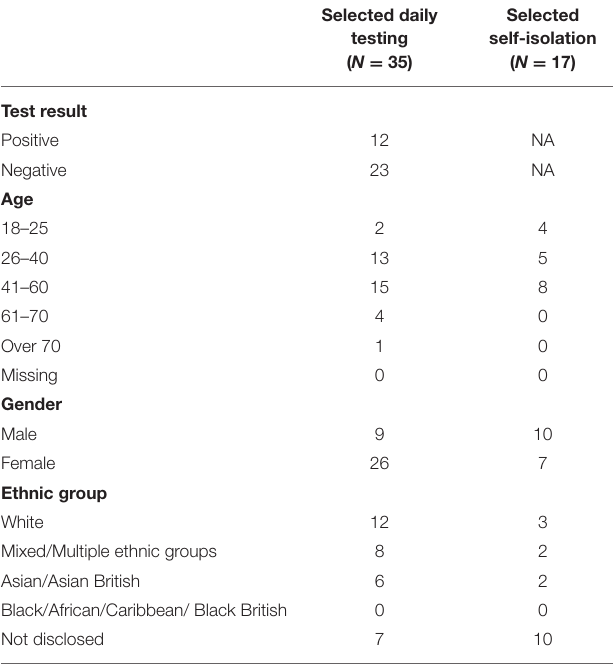
TABLE 1 | Participant